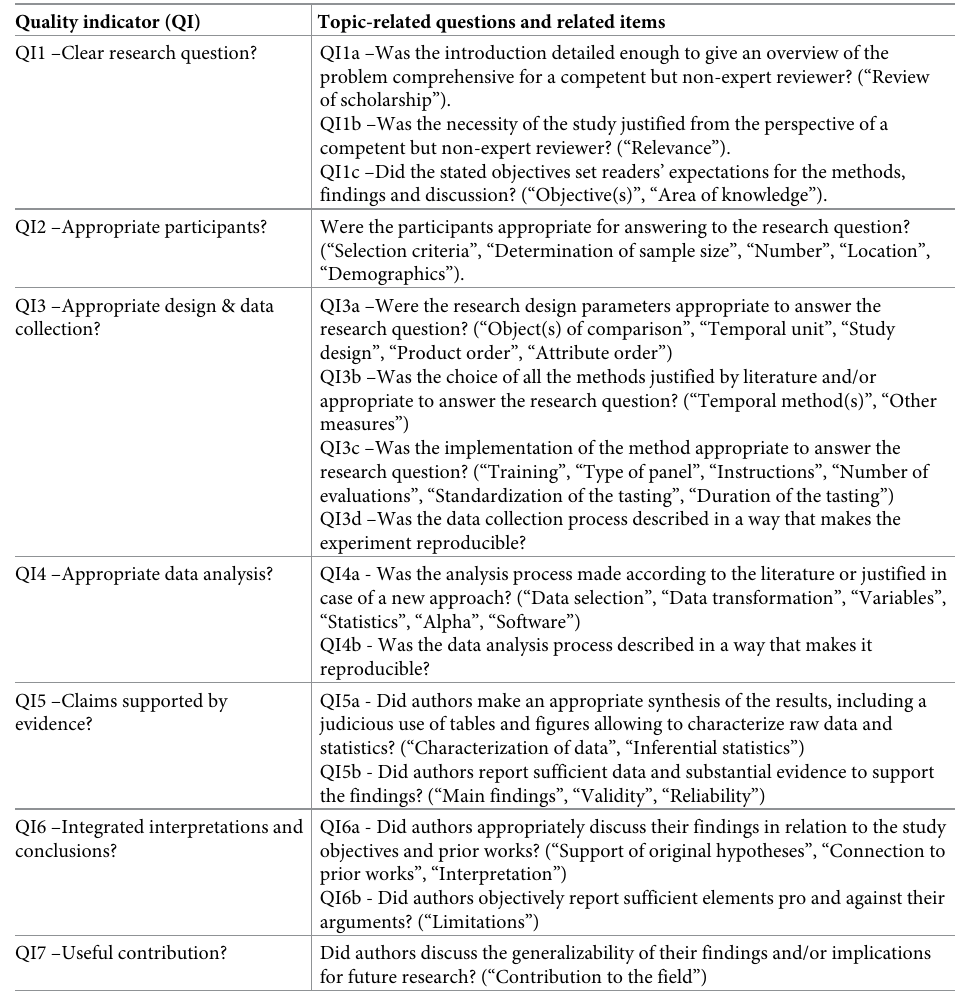
Table 6. Indicators of quality derived from